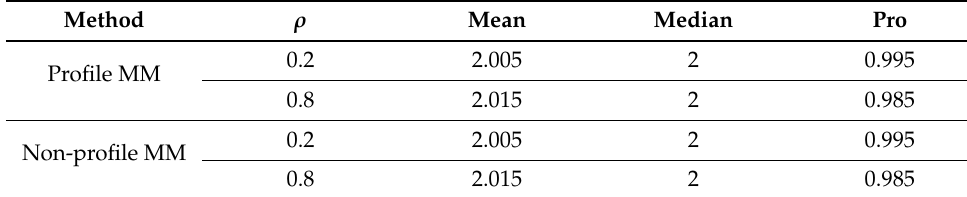
Table 5. The mean, median, and the proportion (Pro) of ˆ M in Scenario 3.